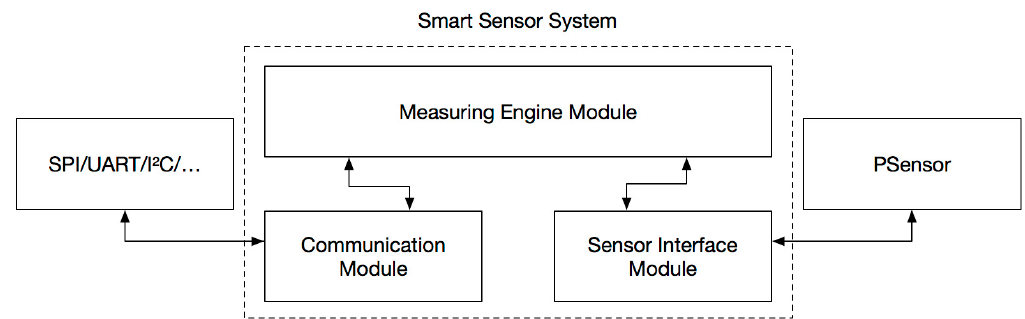
Figure 1. Simple Smart Sensor Architecture.